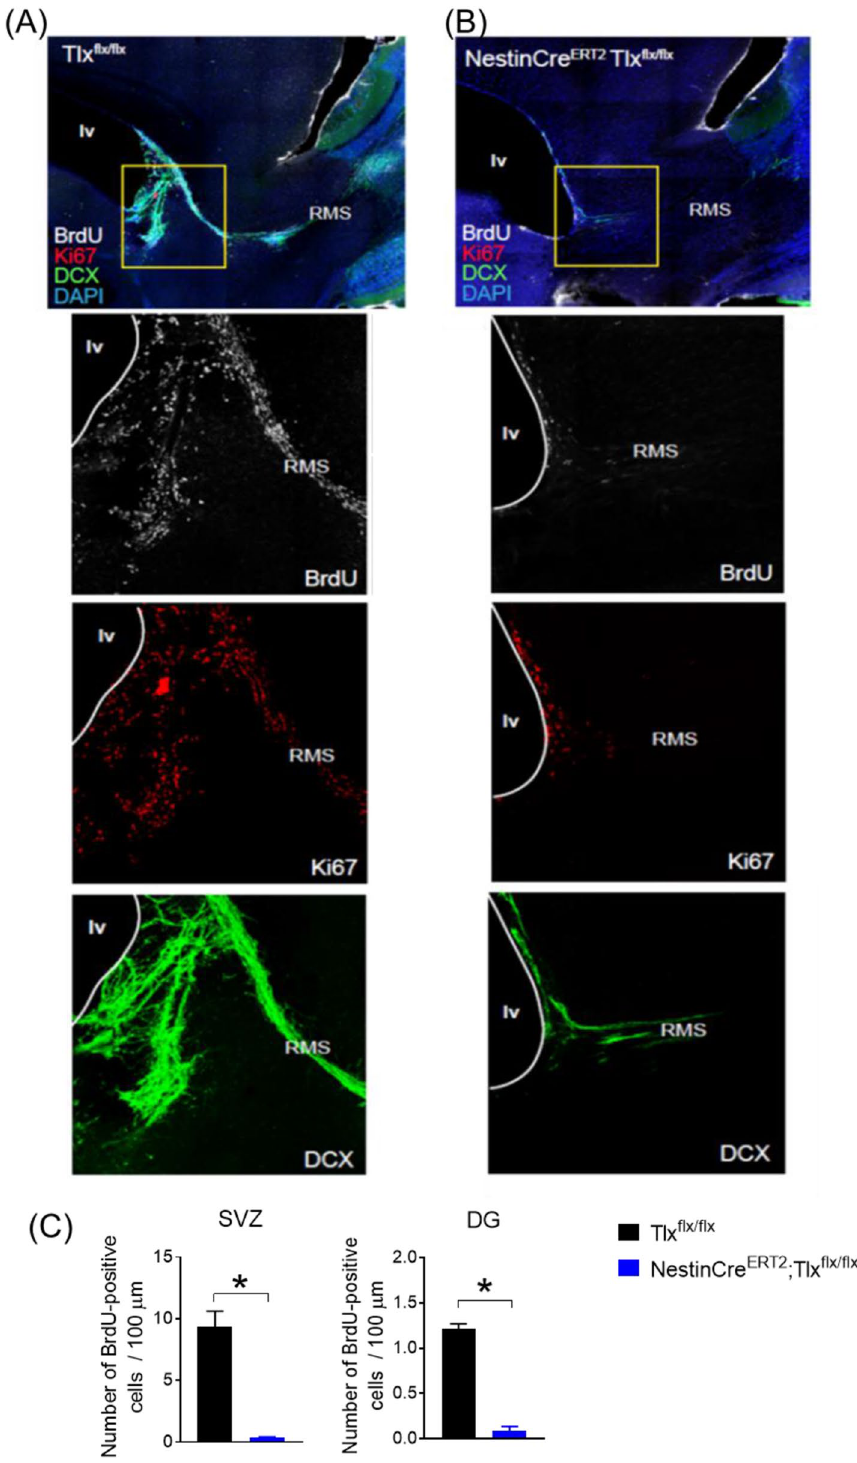
Figure 2. Assessment of newborn cells in the RMS 10 weeks after SNI in control TIx flx/flx ( A ) and NestinCre ERT2 ;TIx flx/flx ( B ) mice. Representative immunofluorescent images of the SVZ and RMS (first row) and high magnification of boxed region (lower panels) displaying BrdU-, Ki67- and DCX-labelled cells. A major absence of neurogenesis is still observed in the NestinCre ERT2 ;TIx flx/flx mice 15 weeks after tamoxifen injections. ( C ) Average number of BrdU-positive cells (per 100 pm) present in the SVZ (left) and DG (right) of either cre- negative or cre-positive NestinCre ERT2 ; TIx flx/flx mice, 15 weeks after Tamoxifen administration (SNI week 11) ( n = 2–3/group; * p < 0.05, unpaired I-test). lv lateral ventricle, RMS rostral migratory stream, DG dentate gyrus, SVZ subventricular